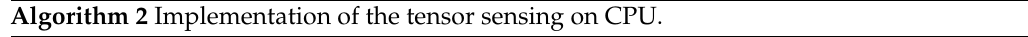
Algorithm 2 Implementation of the tensor sensing on